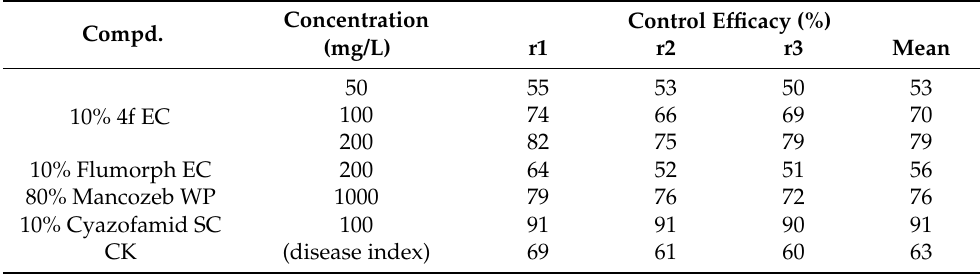
Table 3. The results of compound 4f against CDM in field (2021, Shenyang, open field).